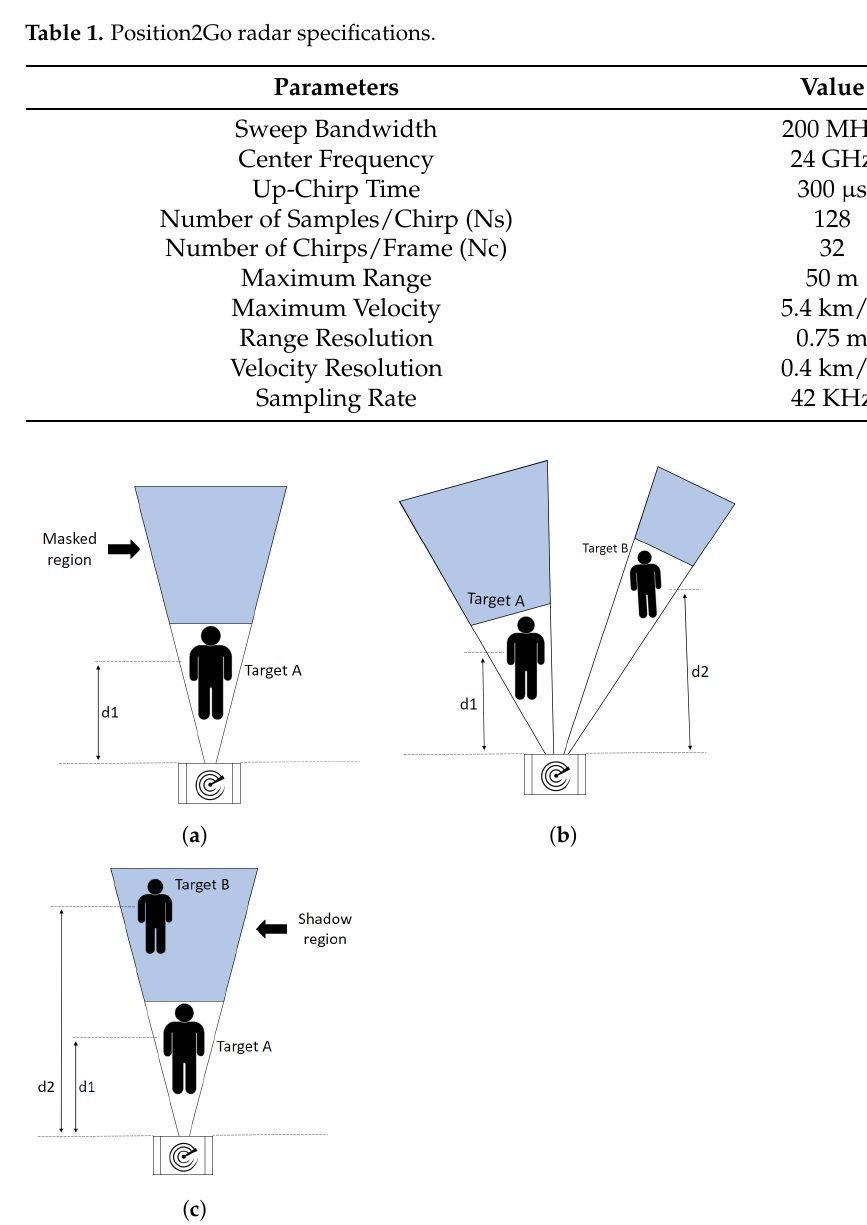
Figure 1. Illustration of the data collection setup. ( a ) One target in range of the radar. ( b ) Two targets in range of radar, both visible to the radar. ( c ) Two targets in range of radar, only one visible to the